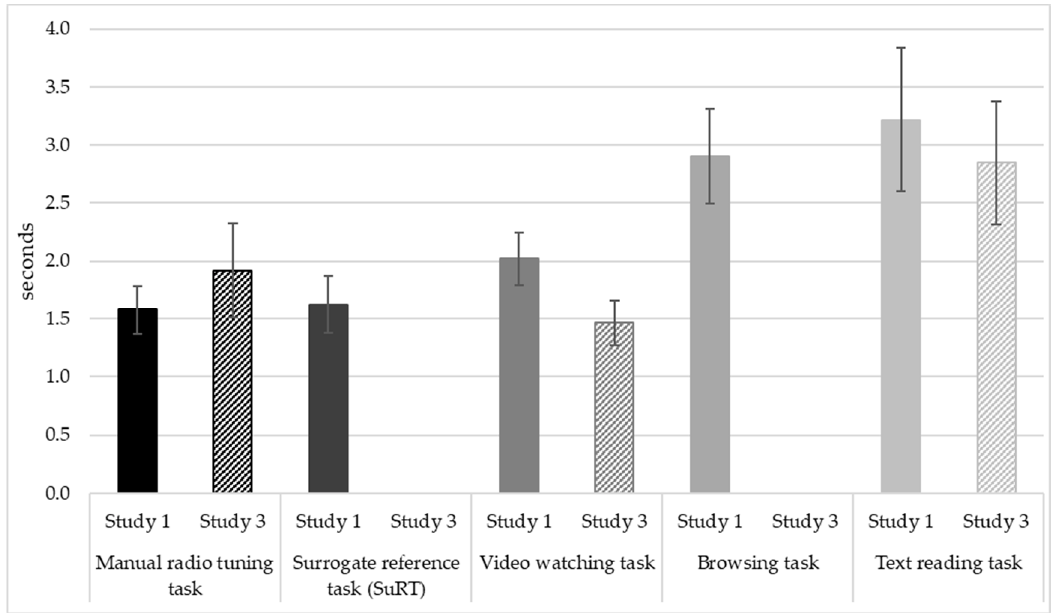
Figure 3. Mean gaze duration towards the NDRTs (in seconds) depending on the executed non-driving related task for study 1 in the simulator and study 3 on the test track.